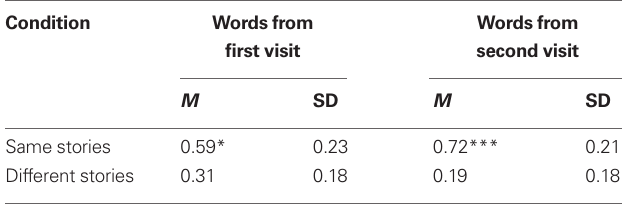
Table 1 | retention performance as a function of when novel words were encountered.